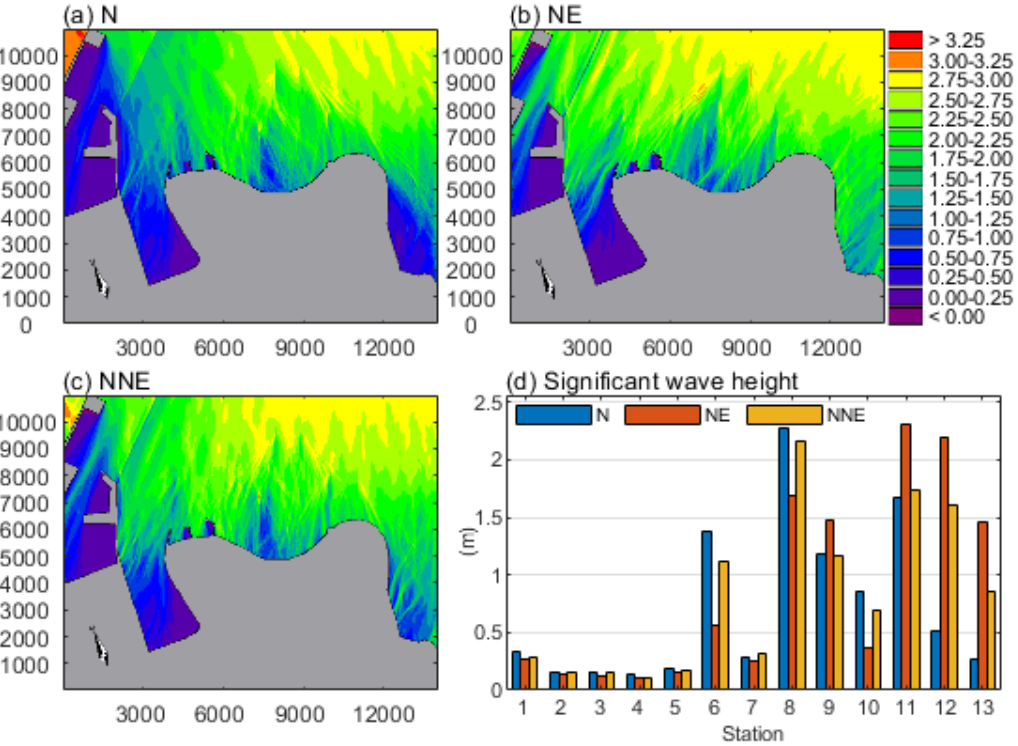
Figure 6. ( a – c ) Simulation of waves transferred from the open sea to the levee from three directions (N, NE, and NNE) in the MIKE 21 PMS model simulation and ( d ) significant wave height at the 13 measuring points along the levee.